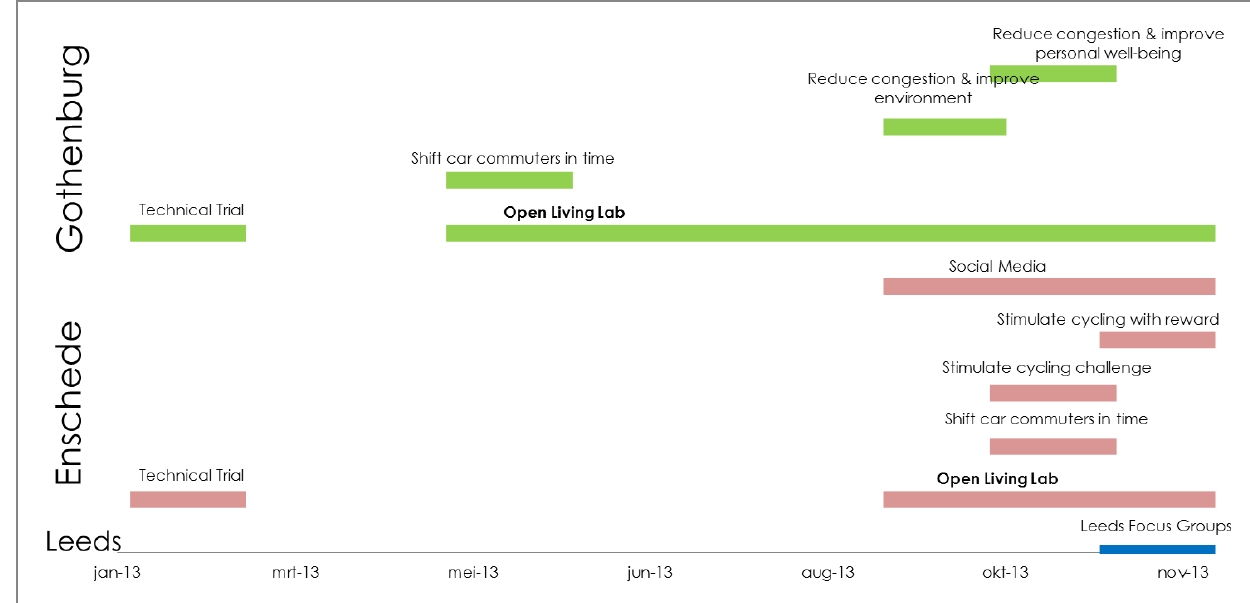
Figure 9. Timeline of experiments in Enschede, Gothenburg and